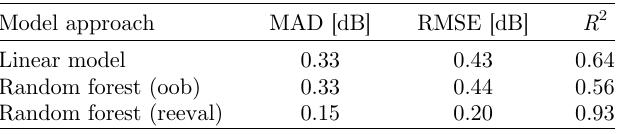
Table 5. Reevaluation performance parameters for the mod- elling approaches: mean absolute deviation (MAD), root mean squared error (RMSE) and coef fi cient of determination ( R 2 ) for the three frequency ranges.